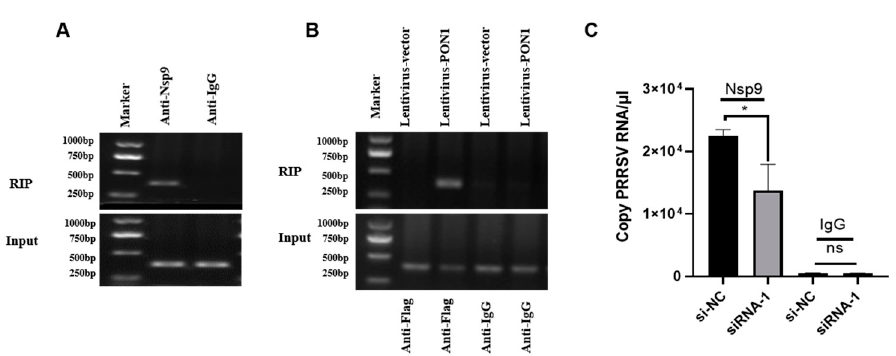
Figure 5. PON1 regulates the interaction of PRRSV Nsp9 with viral RNA. ( A ) Nsp9 binds to PRRSV RNA. PAMs were infected with PRRSV for 24 h, and cell lysates were subjected to RIP with an anti ‐ Nsp9 pAb. The control IgG was included as a negative control. The RNA pulled down by the im ‐ munocomplexes was checked by RT ‐ PCR. ( B ) The relationship between PON1 and viral RNA. Flag ‐ PON1 was overexpressed by the lentivirus ‐ mediated system in PAMs for 24 h; then, PAMs were infected with PRRSV for 24 h. The cell lysates were subjected to RIP with an anti ‐ Flag mAb. The isotype control IgG was included as a negative control. The RNA pulled down by the immunocom ‐ plexes was check by RT ‐ PCR. ( C ) Depletion of endogenous PON1 decreases Nsp9 binding to viral RNA. PON1 was knocked ‐ down by siRNA ‐ 1; then, the PAMs infected with PRRSV were collected at 6 hpi and subjected to RIP with an anti ‐ Nsp9 pAb or control (IgG). The virus RNA level was determined by qPCR. Data are presented as the mean ± SD. ns, p > 0.05 ; *, p < 0.05; The p ‐ value was calculated using Student ʹ s t ‐ test (two ‐ tails).